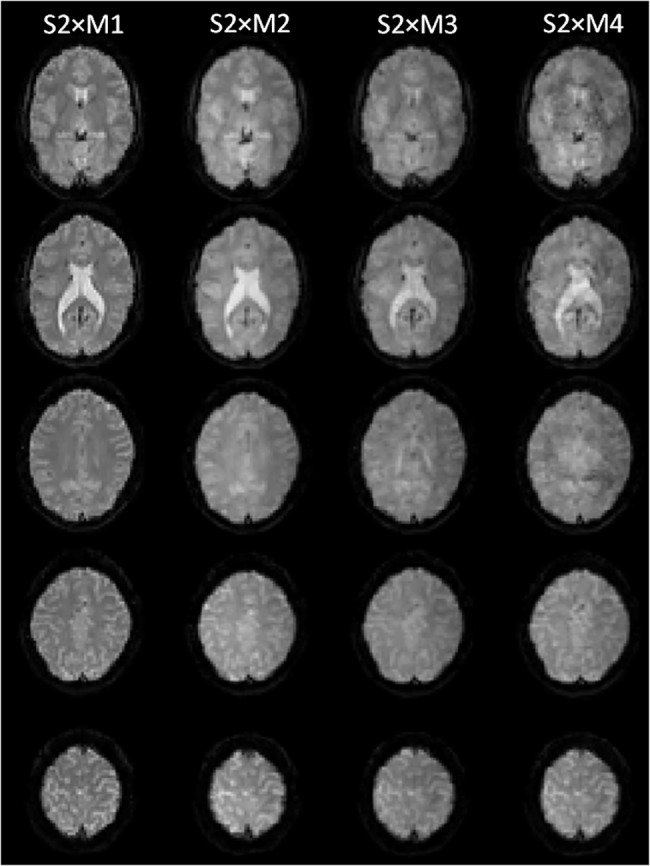
Selected slices of unprocessed EPI data sets for different M-factors from one subject.